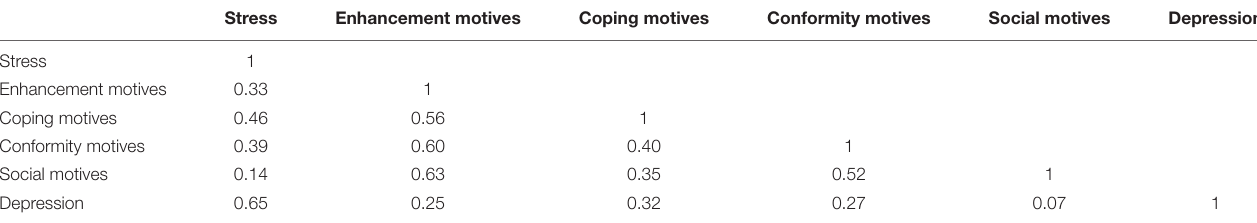
TABLE 2 | Correlations among study variables ( N =